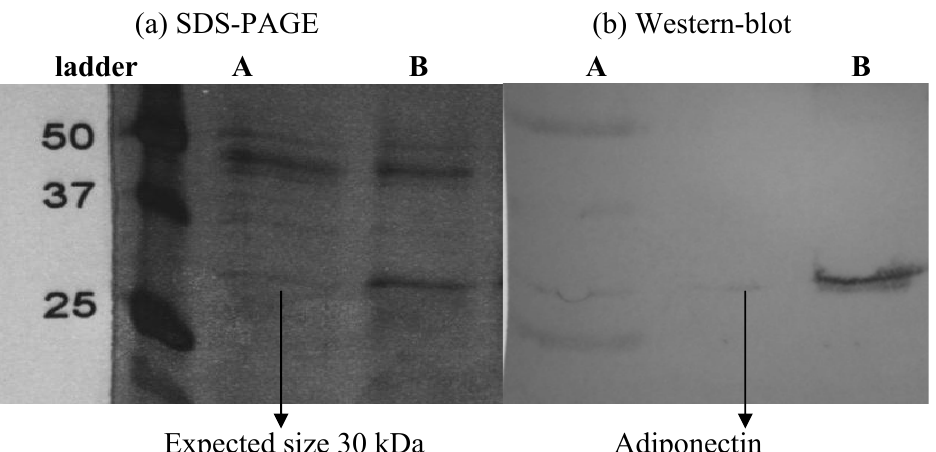
Figure 1. Confirmation of adiponectin expression ( a ) by SDS-PAGE: Presence of a band at 25-37 kDa; ( b ) and Western